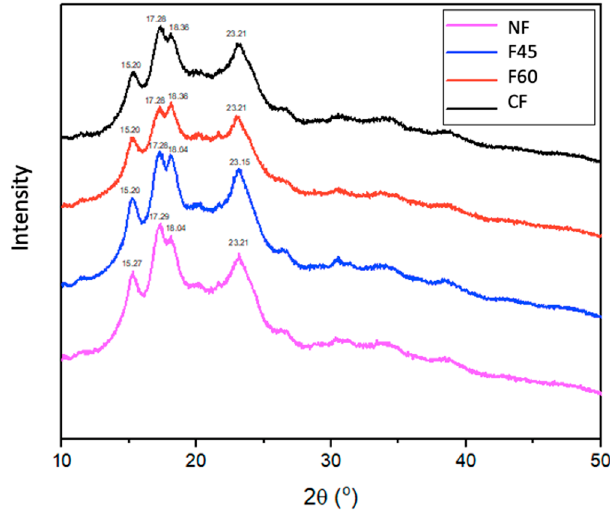
Figure 3. X-ray diffraction (XRD) diagrams of Maya nut flours under different drying treatments. NF—naturally dried flour; F45—flour dried at 45 °C; F60—flour dried at 60 °C; CF—commercial NF—naturally dried flour; F45—flour dried at 45 ◦ C; F60—flour dried at 60 ◦ C; CF—commercial flour.